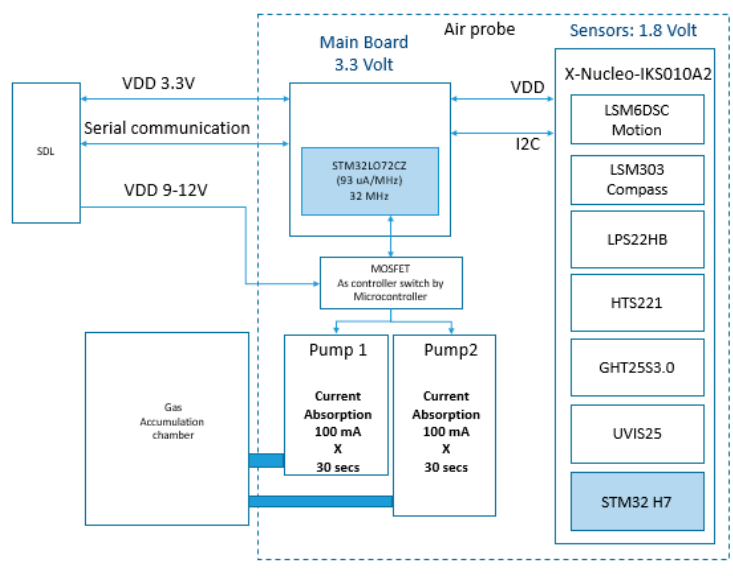
Figure 7. Air probe architecture .